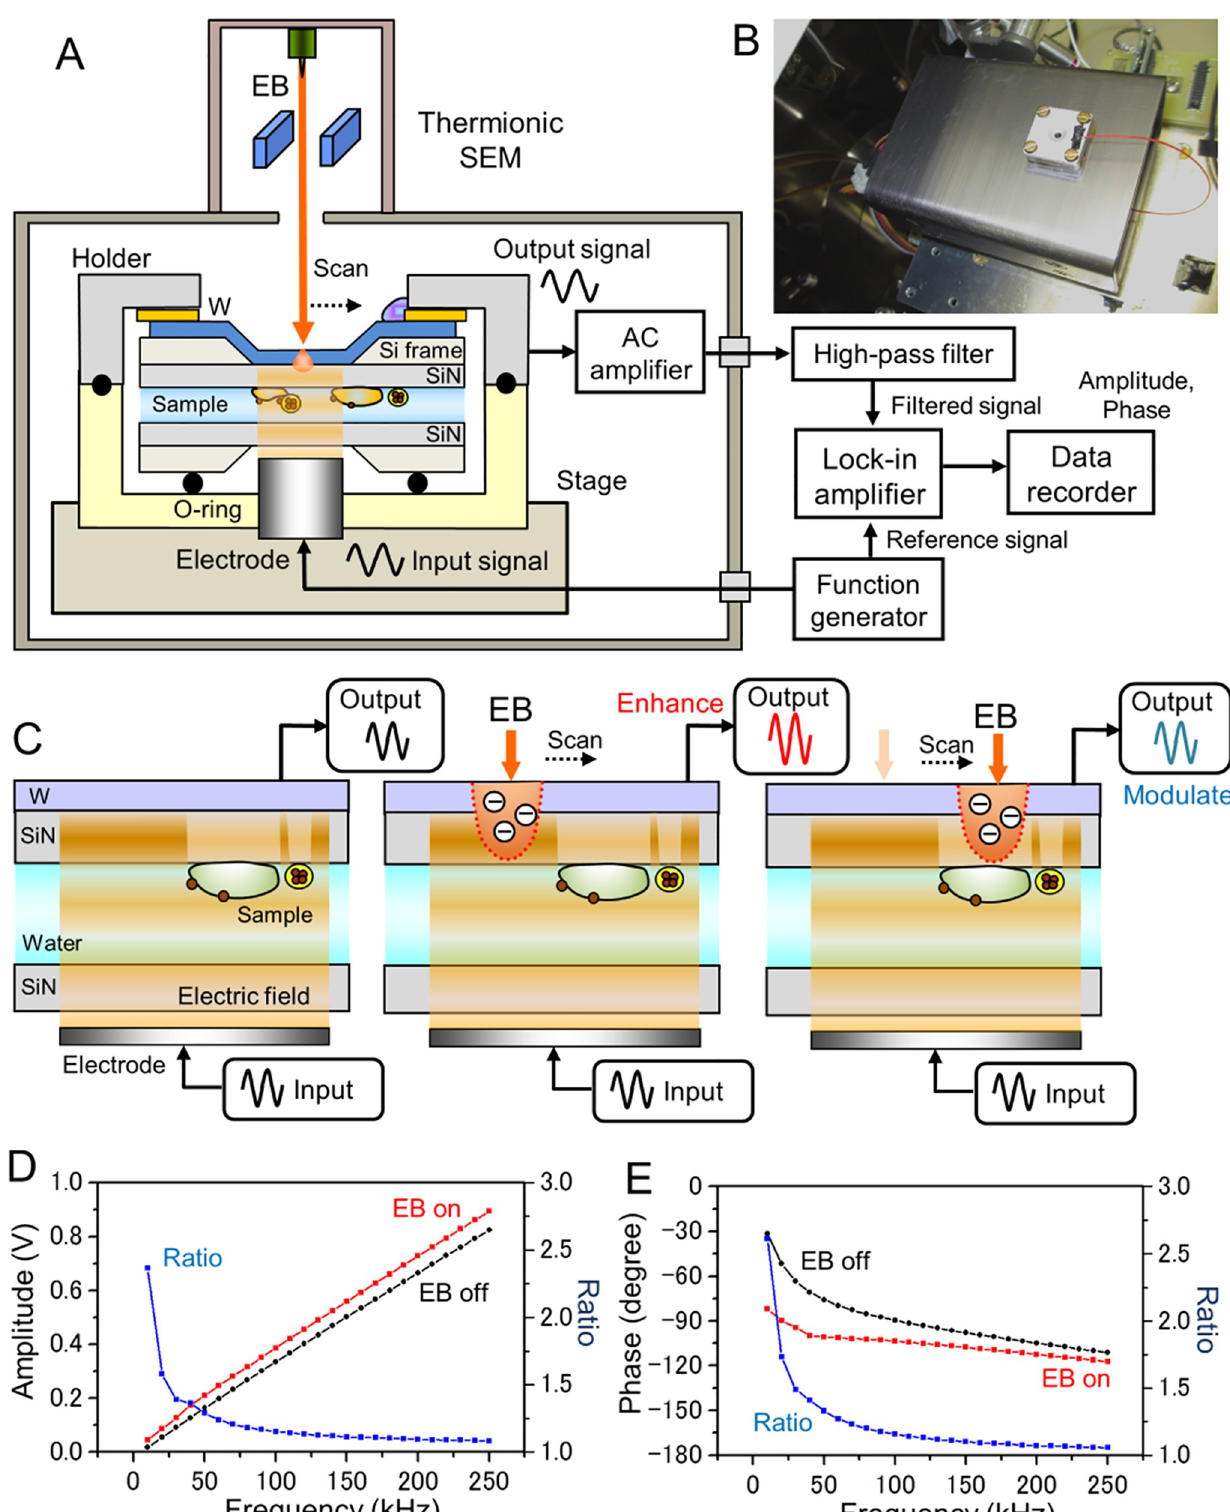
Fig 1. Experimental setup and schematic of the IP-SEM detection mechanism. (A) Schematic of the IP-SEM system. The two SiN films enclosing the liquid sample are sealed by two sample-holding parts. The electrode under the sample holder applies the input voltage signal. The scanning-EB irradiates